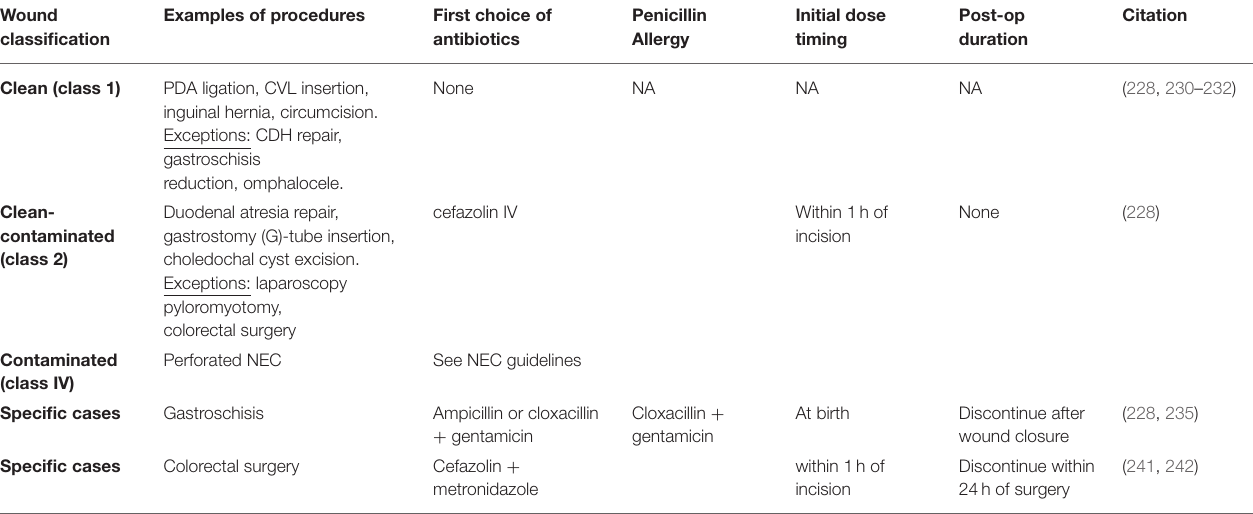
TABLE 2 | Prophylaxis recommendations for surgical site infections in neonates [adapted from Laituri et al.